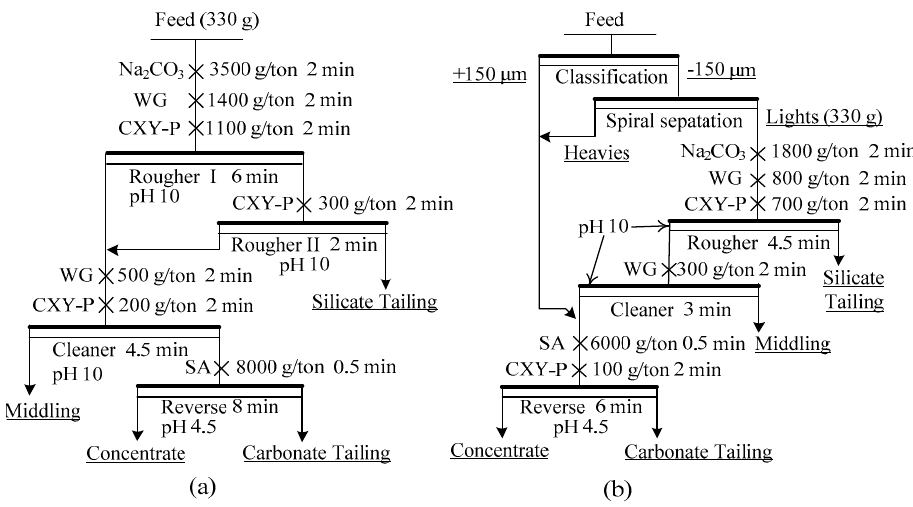
Figure 5. The flotation flowsheet for the conventional process ( a ) and the new process ( b ).